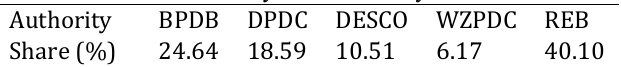
Table 4: Share of electricity distribution by Authorities